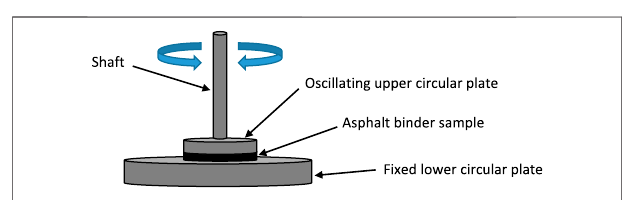
FIGURE 2 | Schematic diagram of the DSR